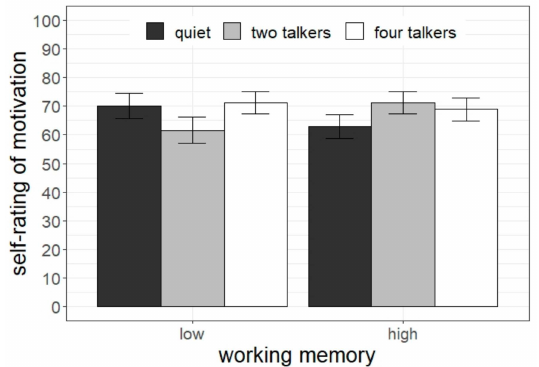
Figure 6. Subjective assessment of motivation as a function of students’ working memory and listening condition. Error bars indicate standard errors.